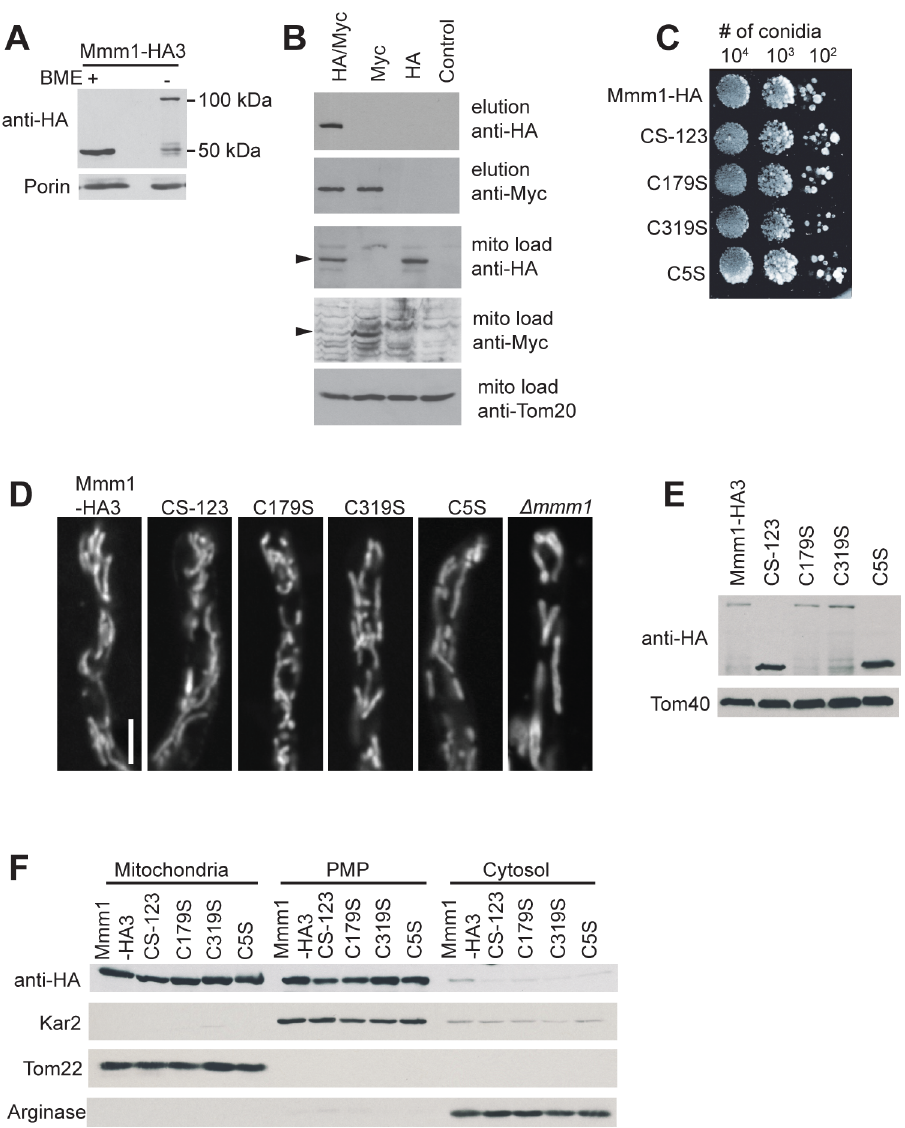
Figure 3. Characterization of N.crassa Cys to Ser Mmm1 mutants. A. The Mmm1-HA protein engages in disulphide bonding. Mitochondria (30 m g) were treated with cracking buffer that either did ( + BME) or did not (-BME) contain b -mercaptoethanol. Samples were subjected to SDS-PAGE, transferred to nitrocellulose and analyzed by Western blotting for the indicated proteins. B. Coimmunoprecipitation of two tagged forms of Mmm1 from a heterokaryon. An unforced heterokaryon consisting of strains Mmm1-HA3 and Mmm1-Myc10 (HA/Myc) was constructed as described in the Methods. Mitochondria isolated from the heterokaryon were dissolved and treated with anti-Myc agarose beads. Elutions from the beads, or total mitochondrial proteins (mito load, to monitor the input level of proteins), were electrophoresed, blotted, and immunodecorated with the antibodies indicated on the right. Controls were an untagged wild type NCN251 strain (control), the homokaryotic Mmm1-HA3 strain (HA), and the homokaryotic Mmm1-Myc10 strain (Myc). Arrowheads on the left indicate the relevant bands in panels containing non-specific background bands. C. Tenfold dilutions of conidiaspores from strains expressing control (Mmm1-HA) and mutant HA-tagged versions of Mmm1 were spotted on plates containing Vogel’s sorbose medium. The plates were incubated at 30 u C for 48 h and then photographed. D. Strains expressing control (Mmm1-HA) and mutant HA-tagged versions of Mmm1 were grown on solid Vogel’s media, stained with MitoTracker Green FM and examined by confocal fluorescence microscopy. Mitochondria in the D mmm1 strain are shown for comparison. Bar represents 10 m m. E. Western blot analysis of Mmm1 Cys mutant crude mitochondria. As in Figure 3A, but mitochondria were only analyzed by non-reducing SDS-PAGE. F. Cell fractionation of the indicated strains as described in Figure 1A except that Tom22 was the mitochondrial